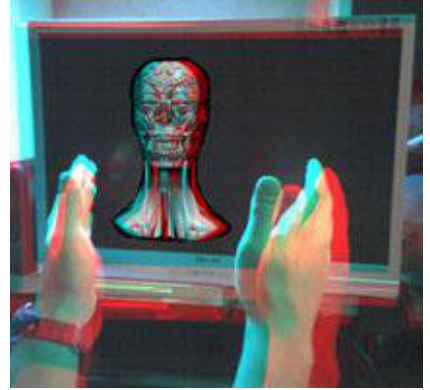
Fig. 1. Concept image of interaction in VIDA Environment (in anaglyph format)